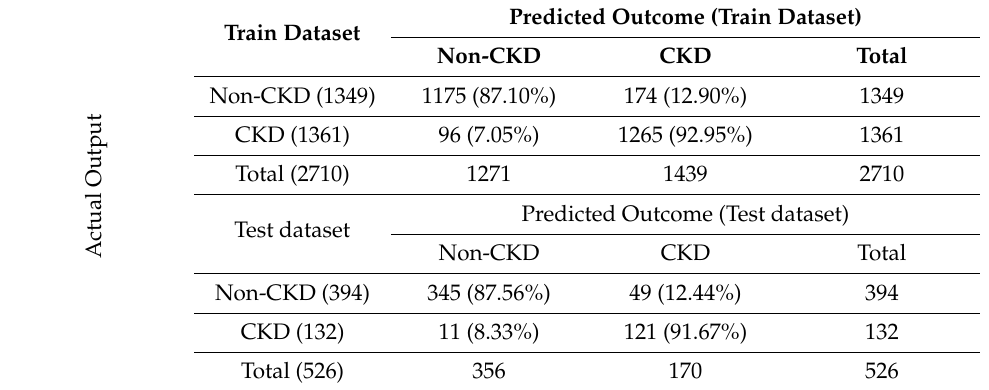
Table 5. The Fisher exact probability test for the train and test dataset.